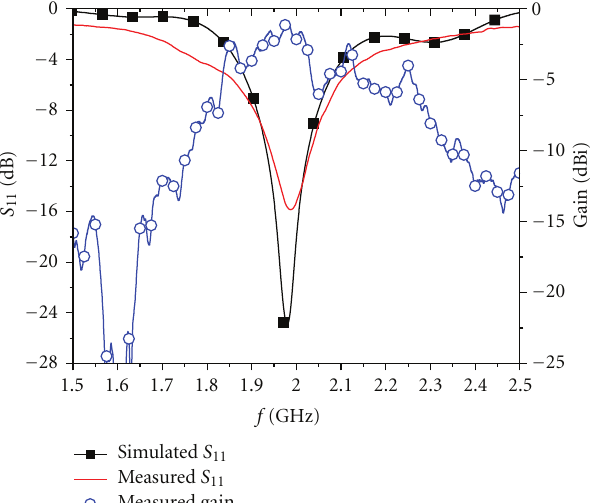
Figure 7: Comparison of simulated and measured return losses for the planar fractal antenna and the measured